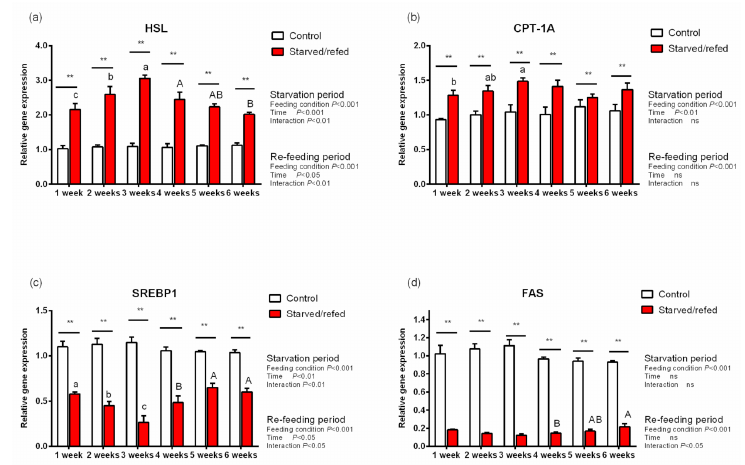
Figure 3. The expression of lipid metabolism genes in the intraperitoneal fat of O. macrolepis exposed to starvation and refeeding periods. Different superscript letters in the same column indicate a significant difference between successive times ( p < 0.05). Significant differences between the two groups at each sampling time are identified with different markers (** p < 0.01; ns, no significant dif- ference). HSL ( a ), hormone-sensitive lipase; CPT-1A ( b ), carnitine palmitoyl transferase 1 isoform A;